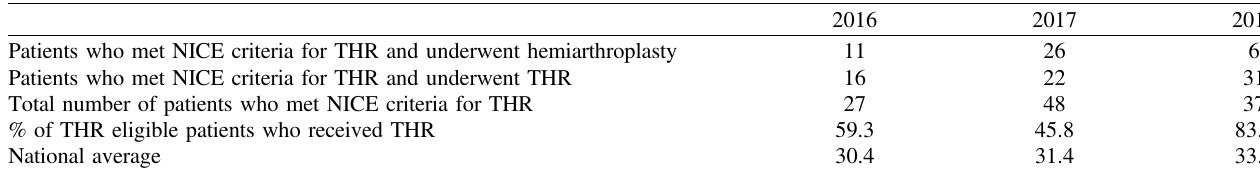
Figure 4. THR patients (%) who ful fi lled NICE criteria and reasons for those who did not. Table 1. Percentage of THR eligible patients who received a